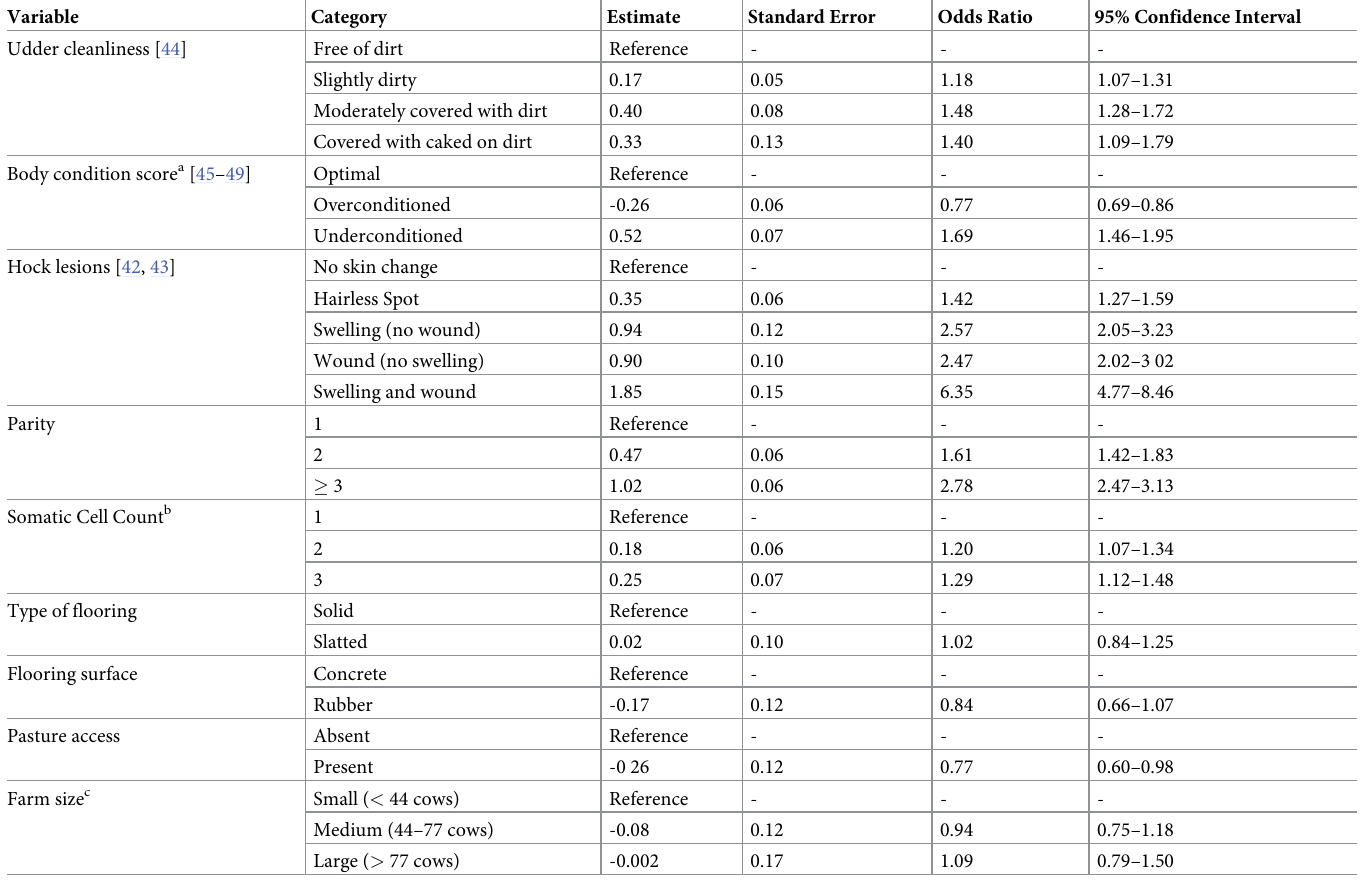
Table 4. Final partial proportional odds model results for increasing locomotion score with covariates (cow level factors and farm characteristics) adhering to the proportional odds